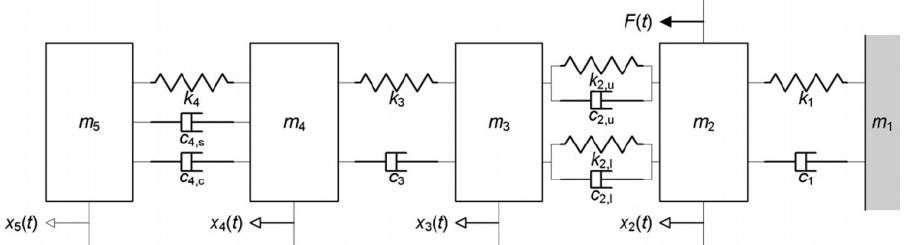
Figure 6. Simplified vibration reduction model of woodpeckers ’ brains as they hit tree trunks [45]. Based on the above analysis, Yoon et al. proposed a new bionic vibration absorption system [45,48]. The system consisted of two layers of metal material, one layer of viscoe- lastic material, and close-packed micro-glass, as shown in Figure 7. Metal layers made of steel and aluminum mimicked, respectively, the beak and skull of the woodpecker. The viscoelastic layer corresponded to the hyoid bone. The porous structure formed by the micro-glass spheres served as spongy bones to absorb the mechanical vibrations gener- ated by the micromechanical devices for a short time. The close-packed micro-glass, with a large number of air gaps, was tightly packed around the micromachined devices, thereby absorbing short-duration mechanical excitations in a kinetic way. Metal enclosure II was filled with the close-packed micro-glass under mallet tapping, in order to achieve a particle-filling ratio of about 62.5%. The experimental results displayed that the system can control high-frequency vibrations and protect the precision instrument effectively un- der external shock. Figure 7. Bionic vibration absorption system [45]. 3. Bionic Devices Based on Animal Leg The ostrich, horse, cheetah, and other animals can run quickly in complex terrain environments without being harmed by the vibrations caused by the impact of the ground. Their unique leg structure plays an indispensable role in vibration reduction [40] . As shown in Figure 8a, there are usually X-shaped and Z-shaped structures in the legs of birds. Additionally, an X-shaped sponge structure is also found in the skull (Figure 8b).